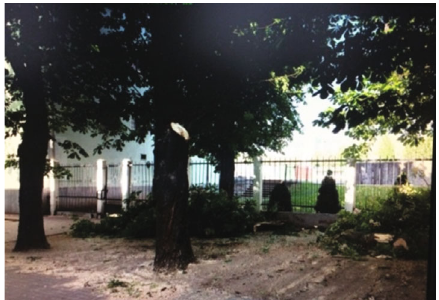
Figure 2: The trunk-branch junction just after branch sawing